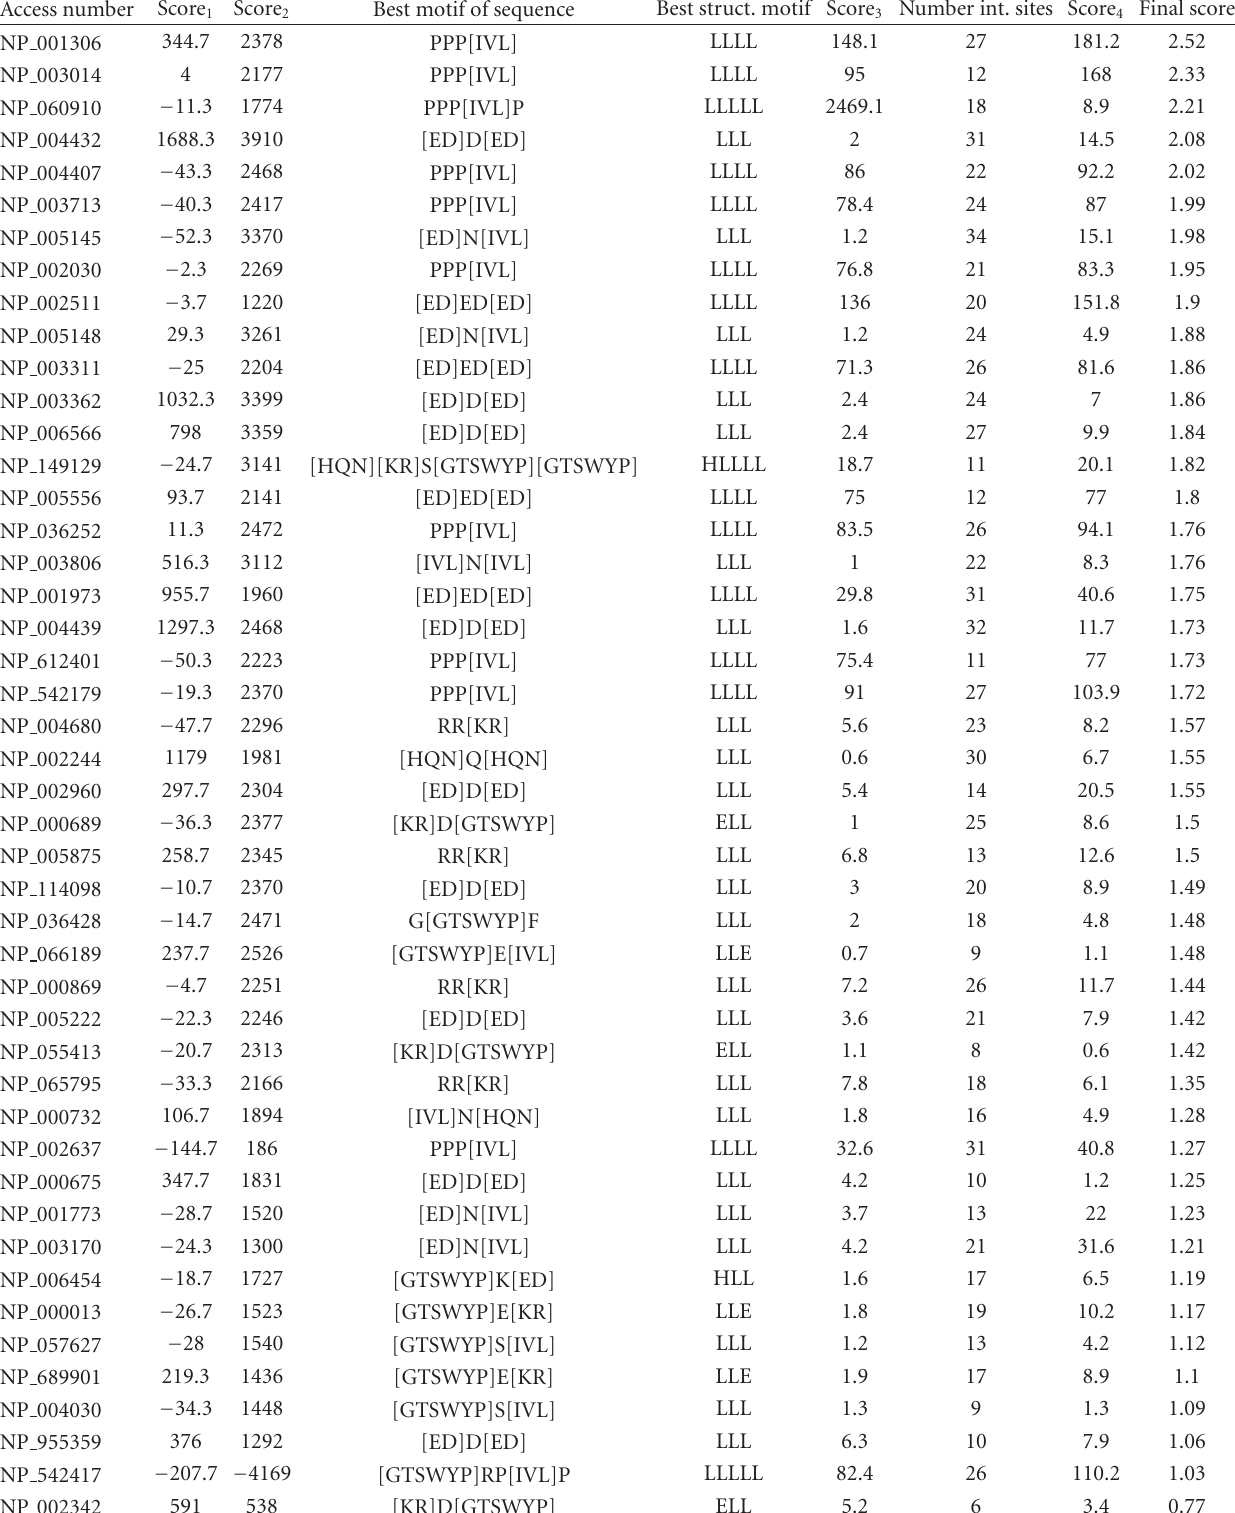
Table 4: Overview of the scores used to rank the putative GRB2 interactors. NCBI protein accession number, Score 1 , Score 2 , the sequence and the structure configuration of the best motif, Score 3 and Score 4 , were reported. The last column showed the final score assigned to each